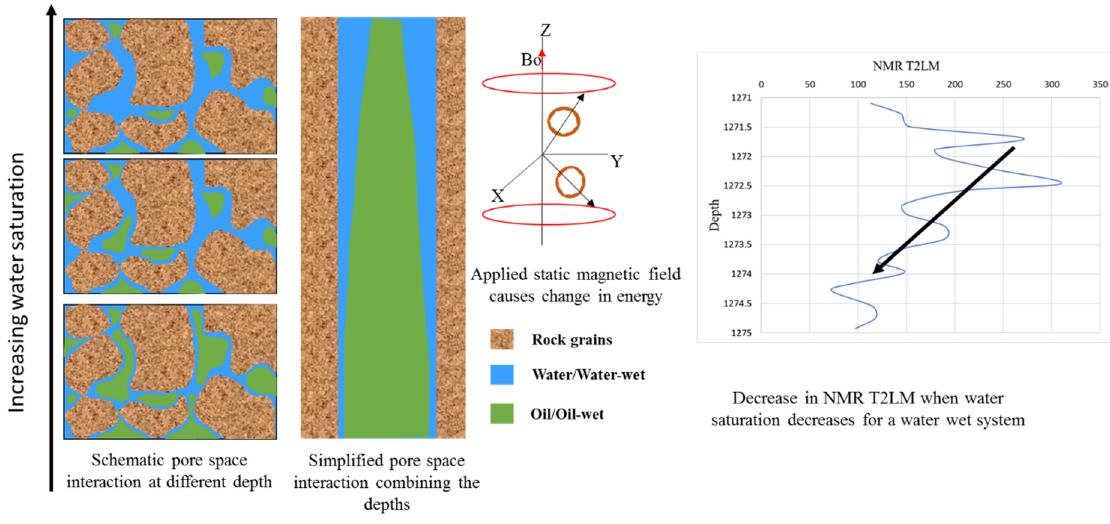
Figure 8. Schematic illustration of NMR T 2 LM distribution as a function of water saturation in an oil-wet condition.